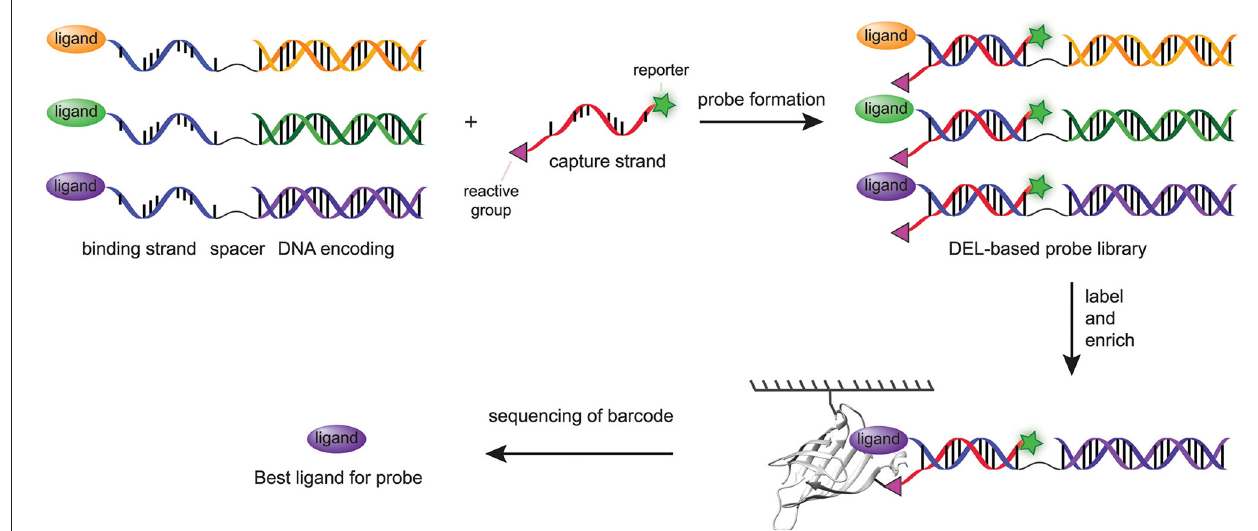
FIGURE 5 | Schematic representation of chemical probes prepared with a combination of DPAL/DTPC and DEL. A DEL library is functionalized with a general ssDNA linked to a dsDNA barcode. The general strand is hybridized with the capture strand. After covalent labeling of the target protein, the target protein is enriched by affinity enrichment. The unbound probes are washed away and the bound probes are analyzed by DNA